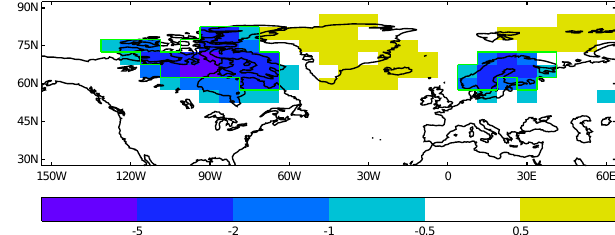
Fig. 9. Difference in the time-means for years 1–100 of surface air temperature ( K ) between the synchronous FAMOUS–Glimmer ex- periment and the FAMOUS-only experiment under incipient glacial (“with Glimmer” minus “without Glimmer”). The green line shows the extent of the ice-sheet in FAMOUS during these years, as de- fined in the